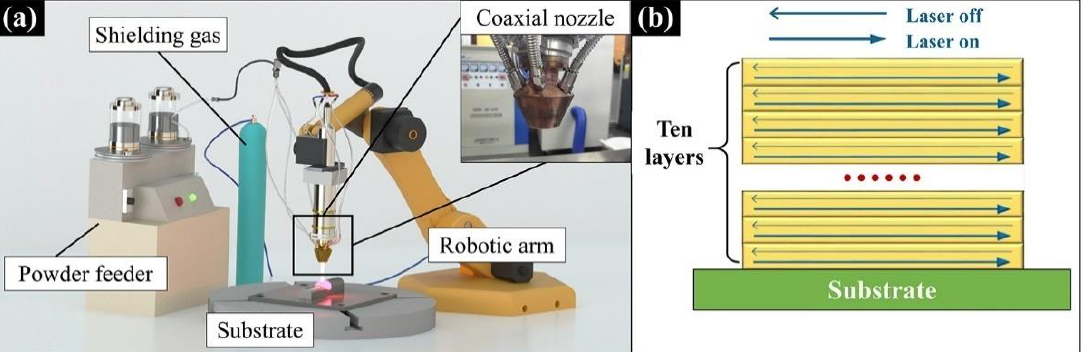
Figure 2. ( a ) Schematic diagram of the LMD-experimental device; ( b ) Schematic diagram of single scanning